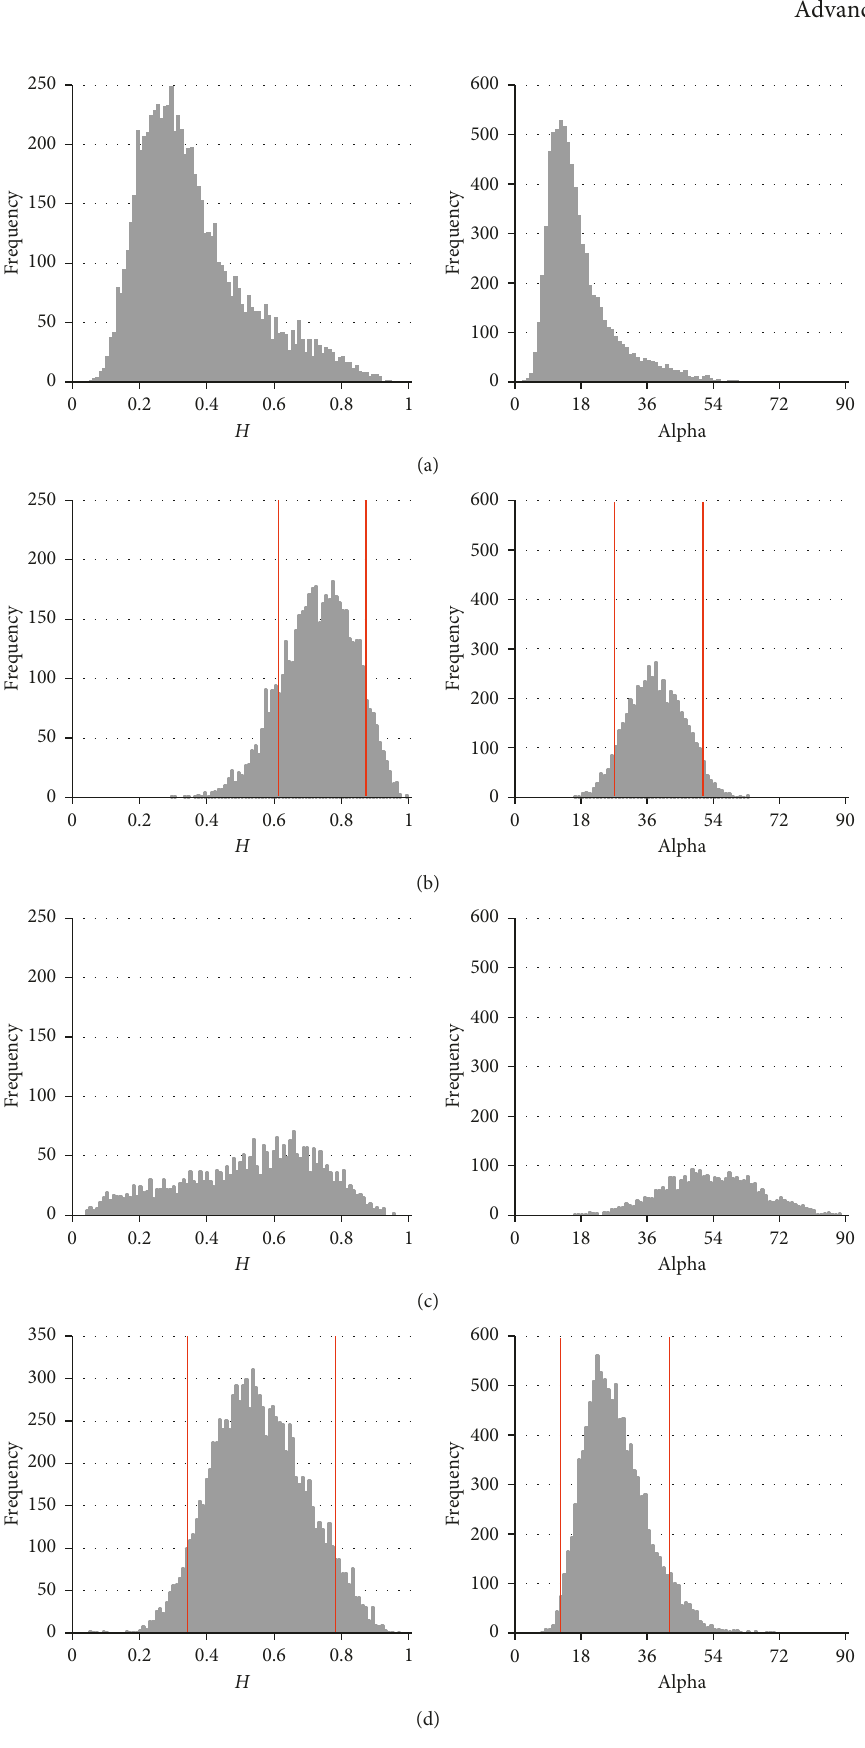
Figure 9: Histograms of H and Alpha for four typical types of surface cover. (a) A bare soil field; (b) a vegetated field; (c) an urban/city area; (d) a field with mixed bare soil and